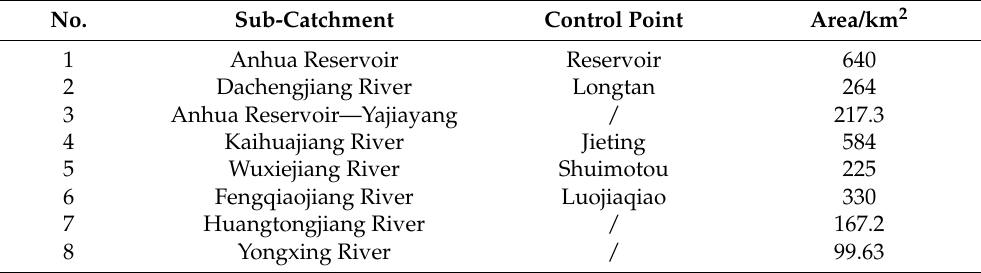
Table 1. Hydrological division of the Puyang River catchment.